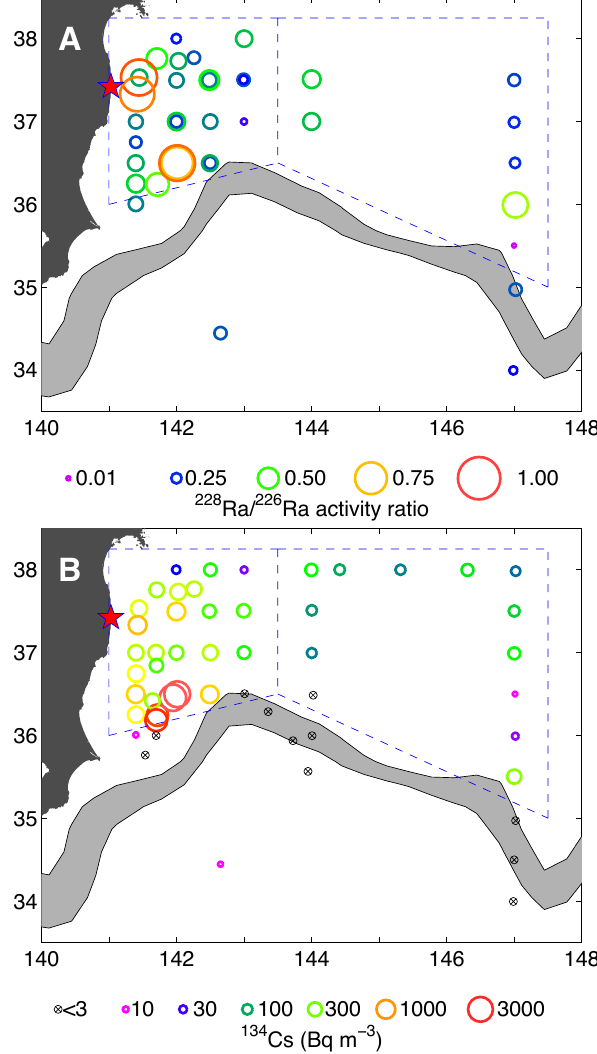
Fig. 2. (A) 228 Ra/ 226 Ra at surface stations. (B) Activities of 134 Cs (Bqm − 3 ) at surface stations (from Buesseler et al., 2012). The gray shaded area is the approximate position of the Kuroshio Current during the cruise. Dashed lines delineate the nearshore and offshore study areas; the Cs flux calculations herein focus on the nearshore zone (50000km 2